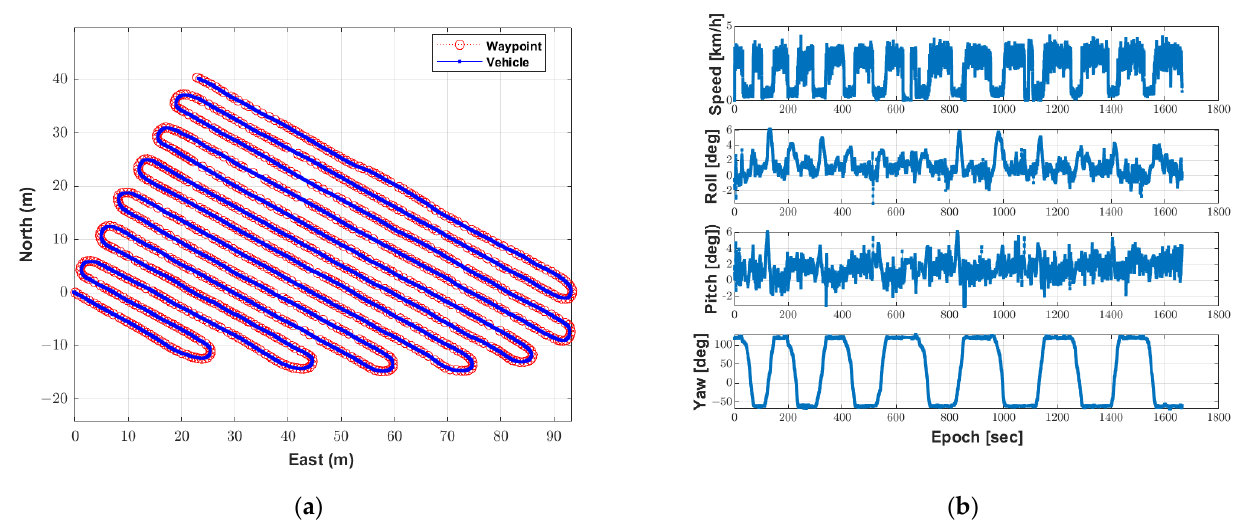
Figure 9. Location, speed and attitude of the speed sprayer during the first test of the autonomous driving-based spraying. ( a ) Location of the speed sprayer with waypoints. ( b ) Speed and velocity of the speed sprayer.